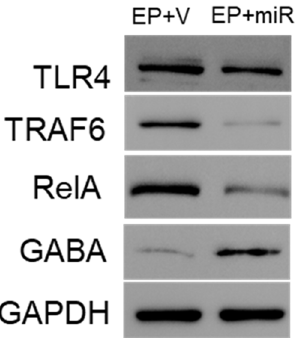
Figure 4: Western blot detected the changes of in fl ammatory mar - kers after injection of exogenous miR - 322 - 5p. Abbreviations: EP + V: epilepsy + vehicle, EP + miR: epilepsy + miR - 322 - 5p intervention group.